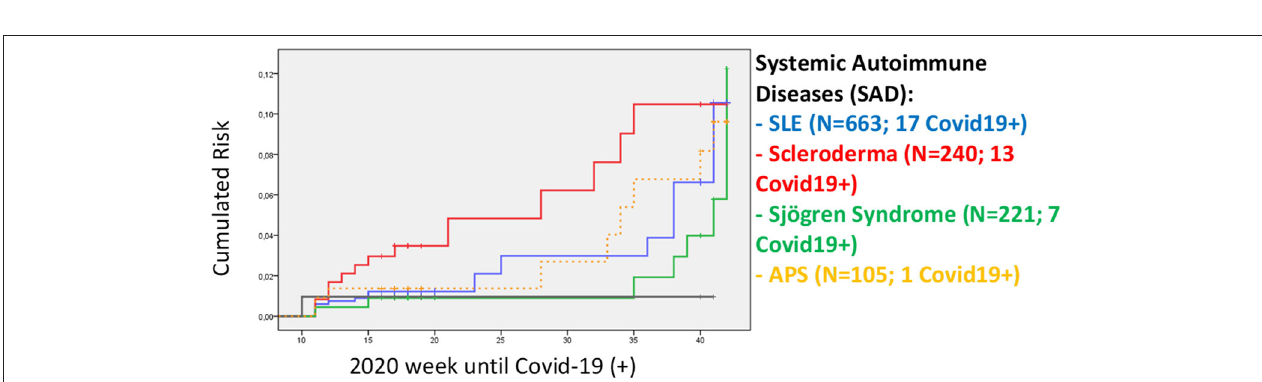
FIGURE 3 | Cumulative incidence of COVID-19 for each of the SAD. Accumulated incidence in the weeks of 2020 for each of the autoimmune diseases. SLE, systemic lupus erythematosus; APS, antiphospholipid syndrome.